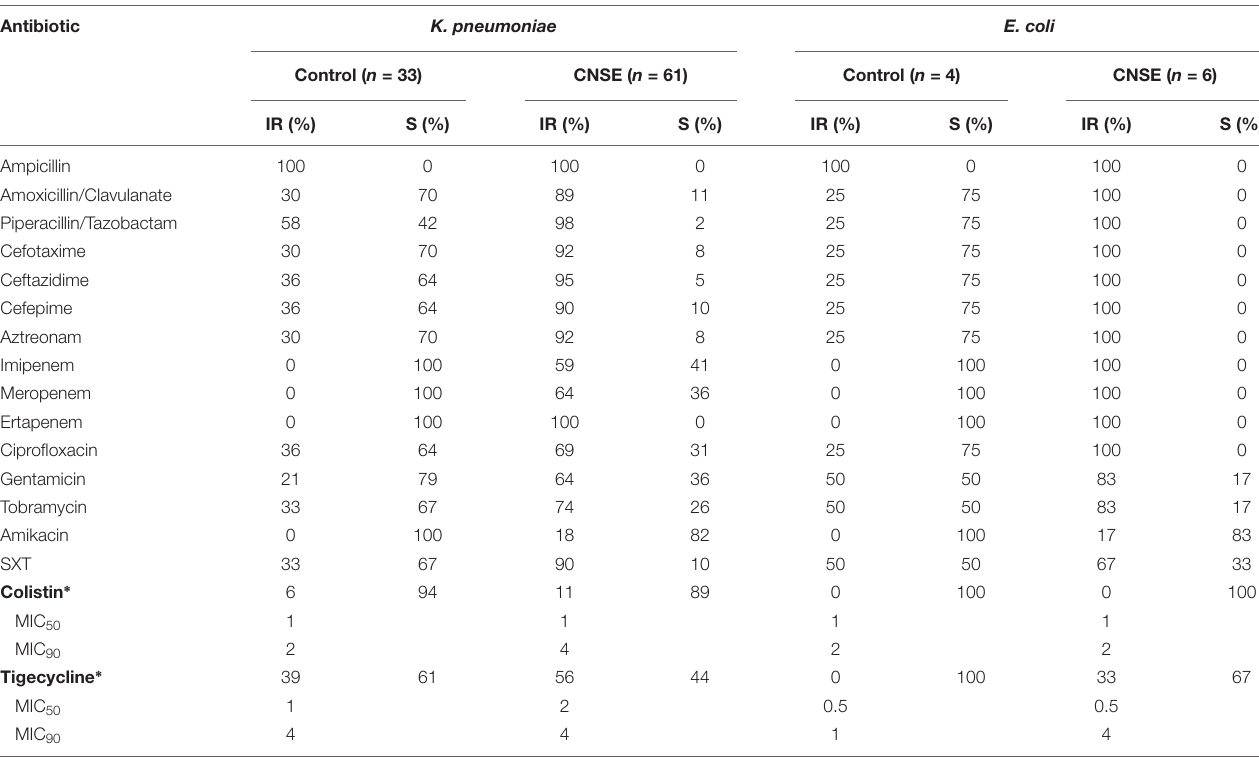
TABLE 1 | Antimicrobial susceptibility of 67 (61 K. pneumoniae and 6 E. coli ) CNSE and 37 (33 K. pneumoniae and 4 E. coli ) control isolates.